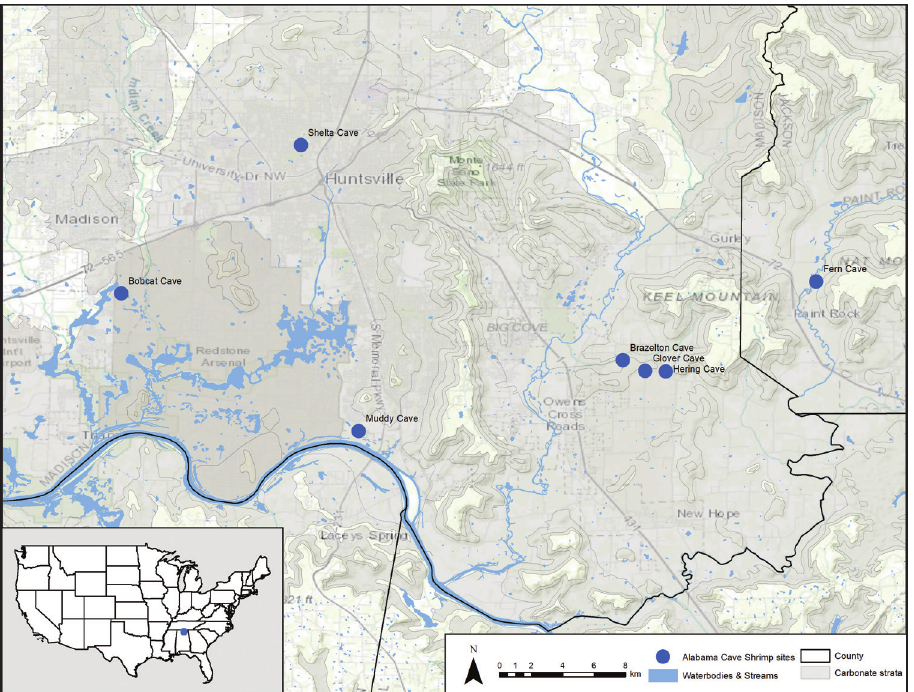
Figure 1. Distribution of the Alabama Cave Shrimp ( Palaemonias alabamae ) in Madison and Jackson coun- ties, Alabama, USA. Carbonate strata are depicted in gray. Alabama Cave Shrimp sites are shown as blue